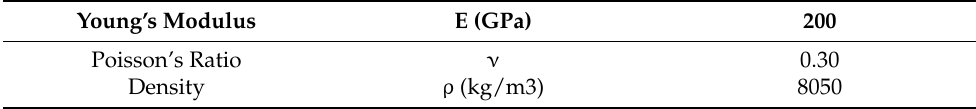
Table 2. Steel Material Properties used in HOSS